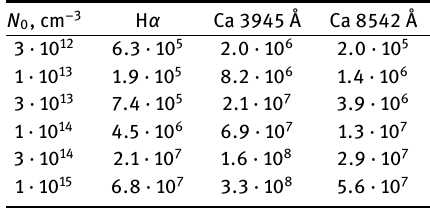
Table 2. Fluxes in the hydrogen and calcium lines in the shock wave model for the velocity V = 20 km/s.